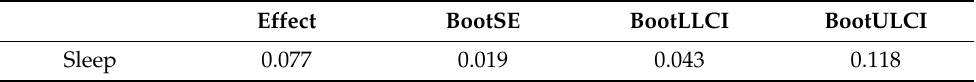
Table 10. Indirect effect of the safe haven support from the father (SHS_F) on sleep